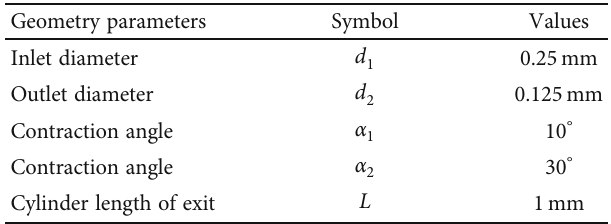
Table 1: Geometry parameters of